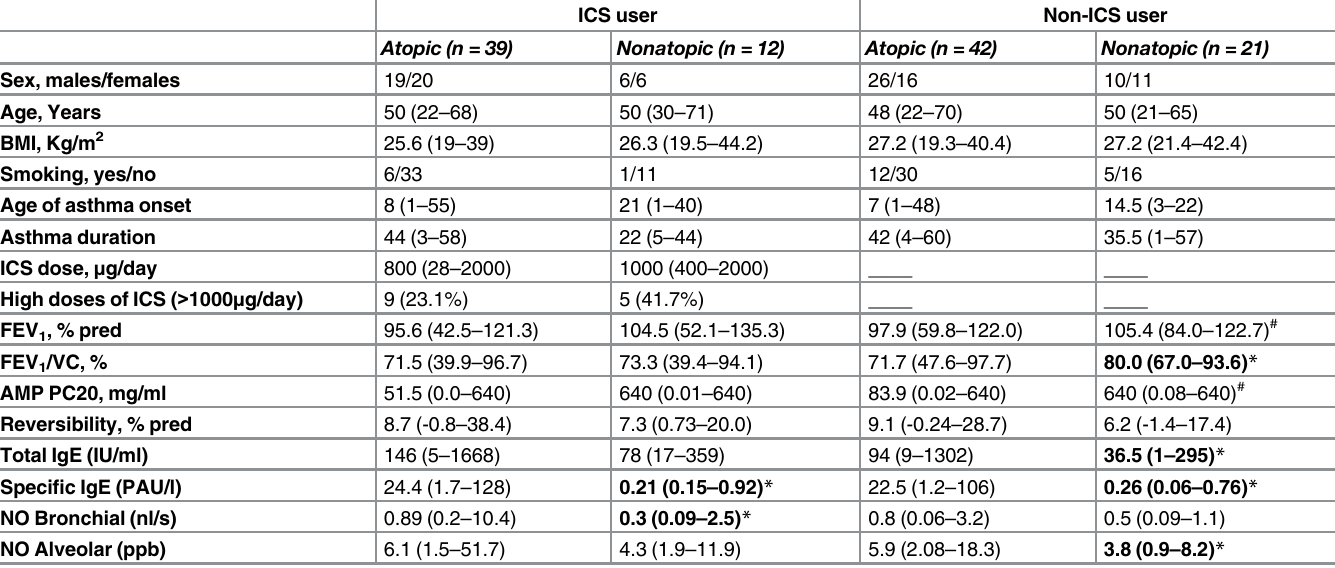
Table 1. Patient